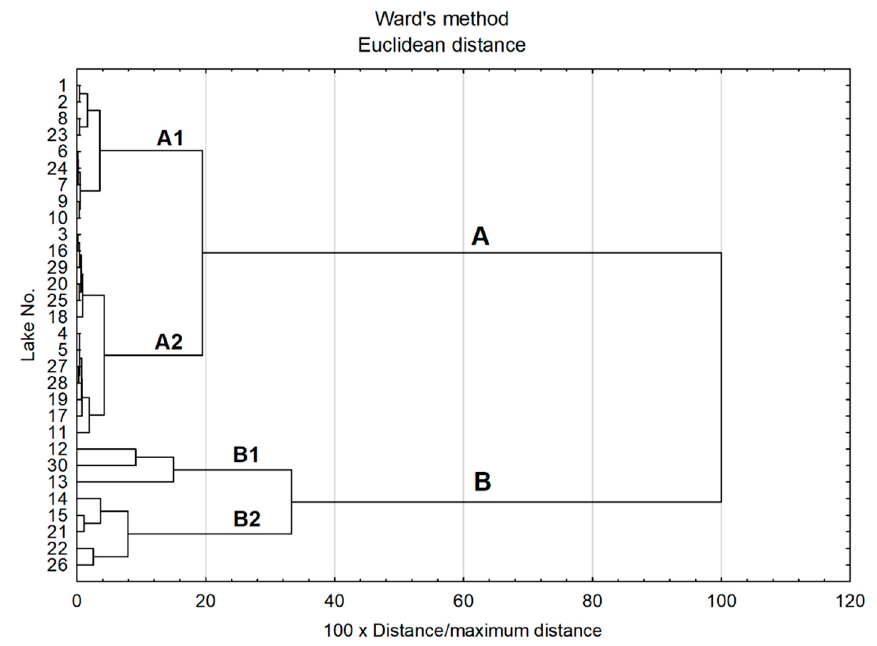
Figure 2. The results of cluster analysis based on physico-chemical parameters—a dendrogram (hierarchical tree) with marked clusters (A–A1, A2 and B–B1, B2).